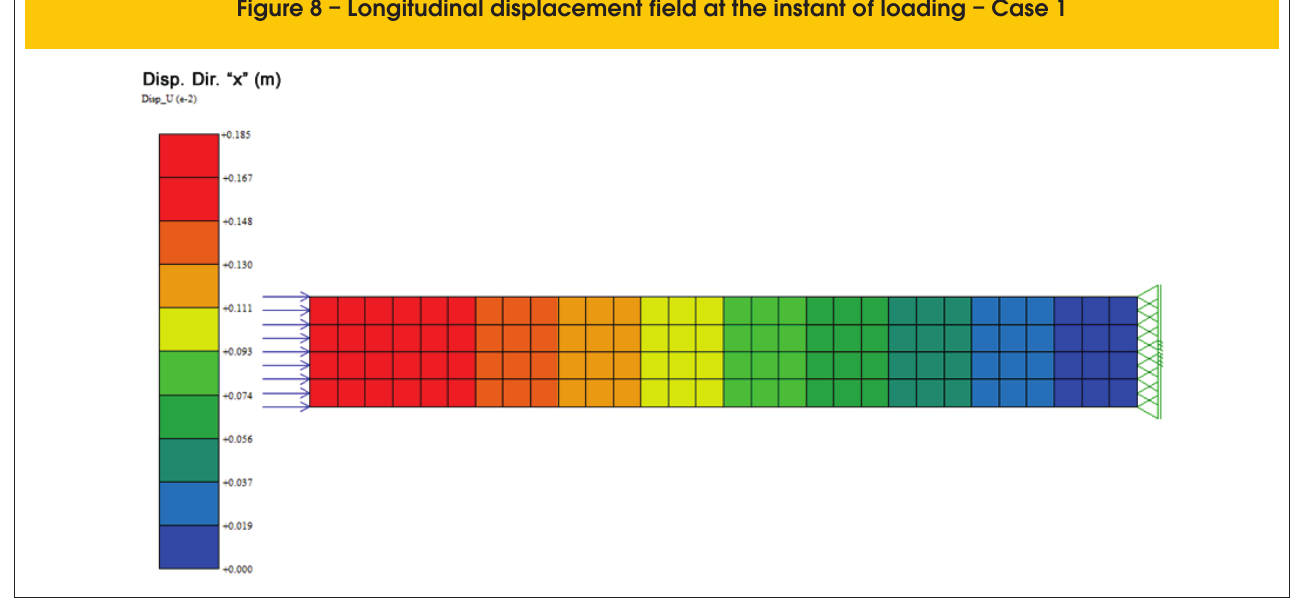
Figure 8 – Longitudinal displacement field at the instant of loading – Case 1